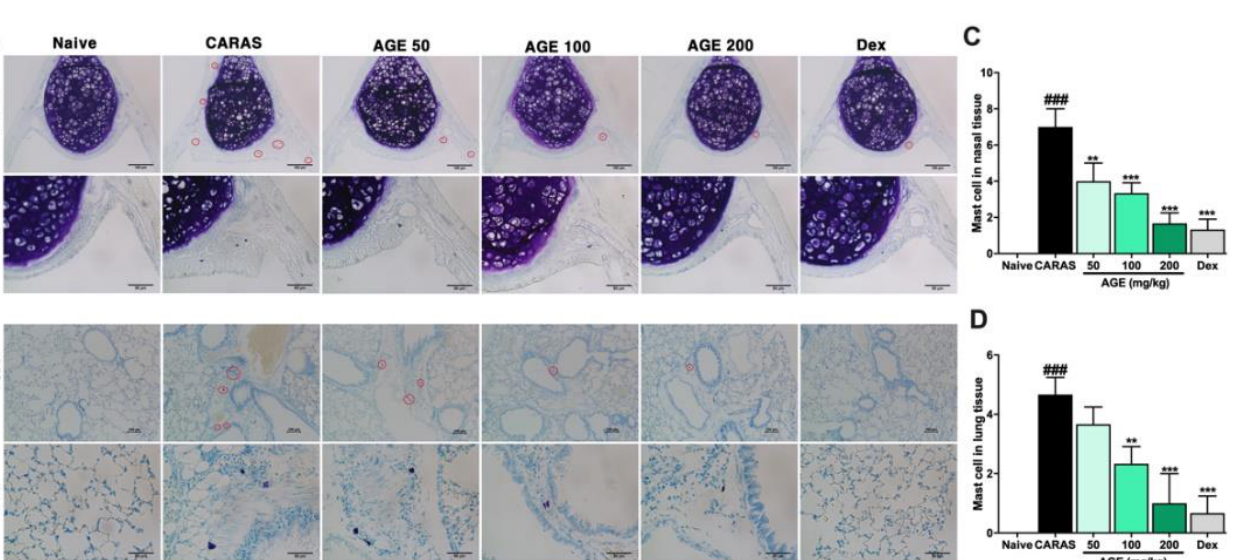
Figure 9. AGE strongly inhibited C48/80-induced mast cell degranulation. ( A ) MTT assay, ( B ) RPMC degranulation ratio, and ( C ) morphology of RPMC under microscopy. RPMCs were pretreated with AGE (0.01, 0.1, 1 mg/mL) or saline for 10 min at 37 °C and then incubated with MTT reagent for 1.5 h (in MTT assay) or incubated with C48/80 (5 µg/mL) or saline for 15 min (in RPMC degranulation experiment). AGE not only significantly alleviated the C48/80-induced RPMC degranulation, but also was not toxic to RPMCs. Each group was performed in duplicate. All results are shown as the mean ± SD. # Compared to naive, * compared to CARAS. ### , *** p < 0.001; ** p < 0.01; * p < 0.05. The black arrow indicates normal mast cell; the red arrow indicates degranulated mast cell. CARAS = combined allergic rhinitis and asthma syndrome; AGE = Artemisia gmelinii extracts; Dex = dexamethasone; C48/80 = compound 48/80. RPMC = rat peritoneal mast cell. Scale bar = 10 µm.